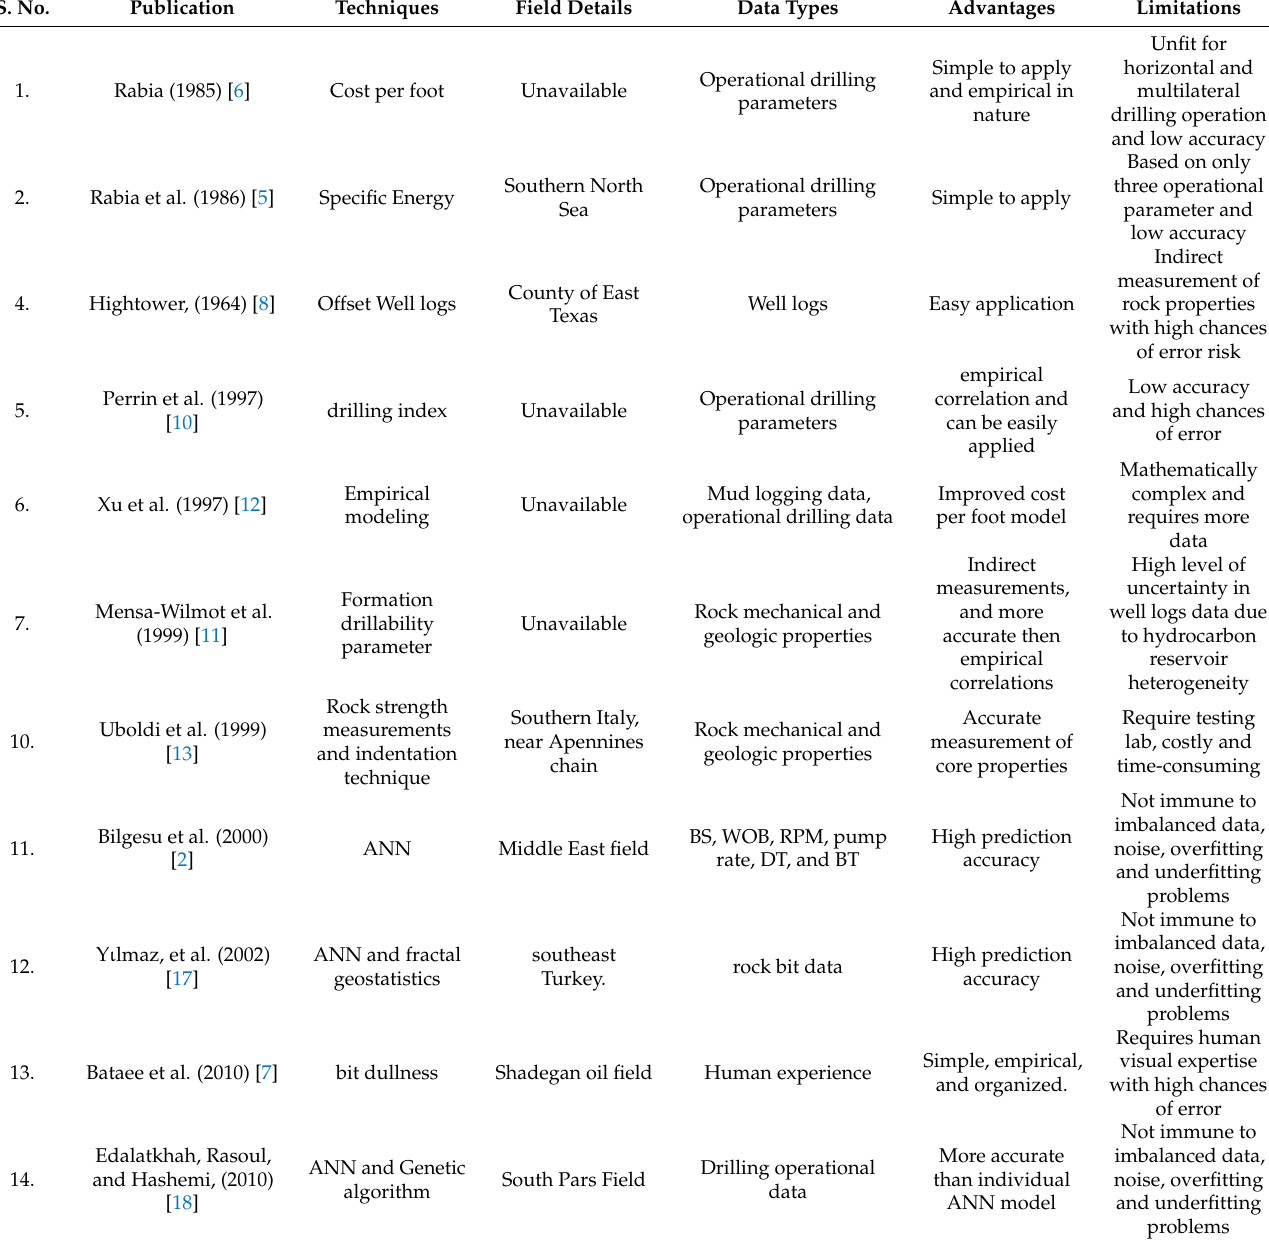
Table A3. A comparative study of significant methods applied for drill bit